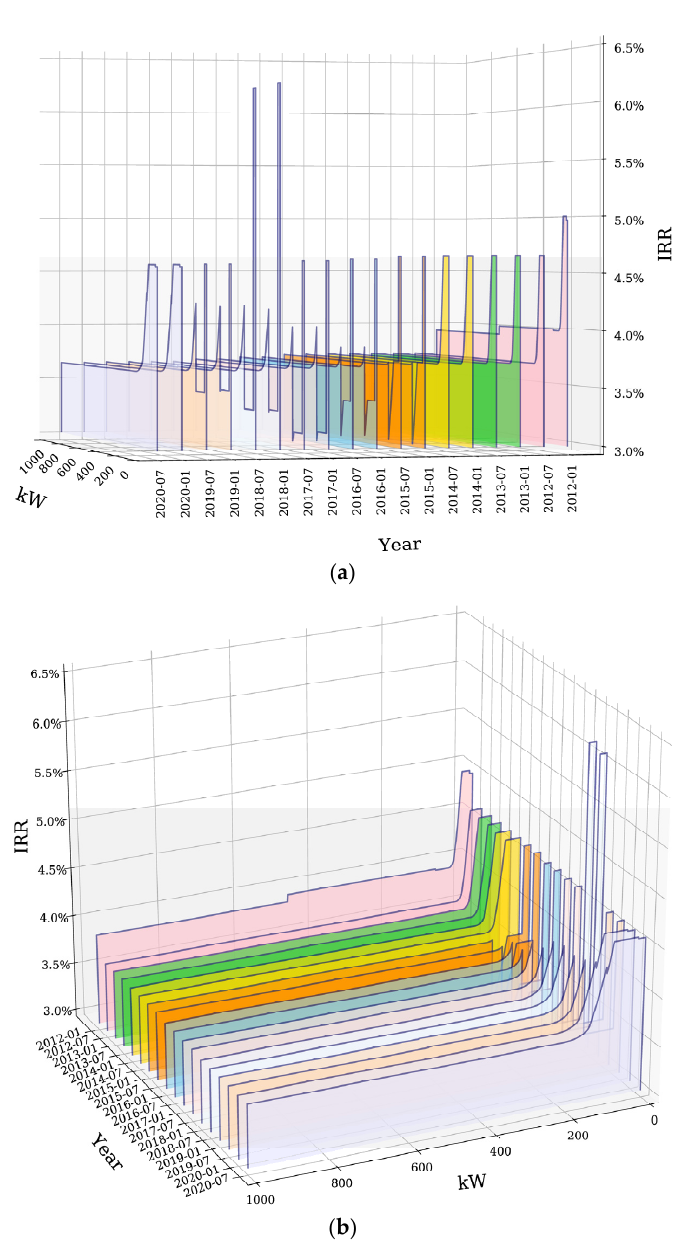
Figure 4. Project IRRs (Internal Rate of Returns) for rooftop PVS with capacity 1 to 1000 kW (2012– 2020), from different angles ( a , b ) Source: